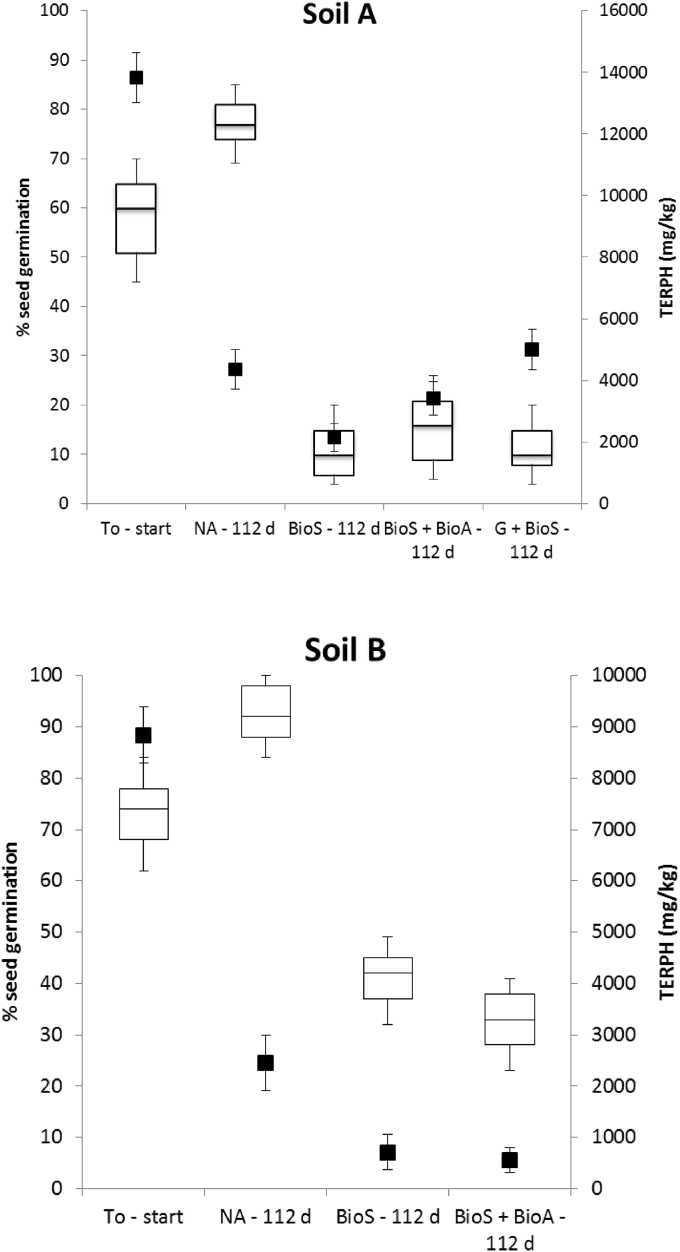
Mean seeds germination percentage (whisker boxes) and total extractable hydrocarbons resolved (aliphatic + aromatic compounds; black squares) at the onset and after 112 days for each treatment in soil A and B (error bars indicate standard error of the triplicate results).